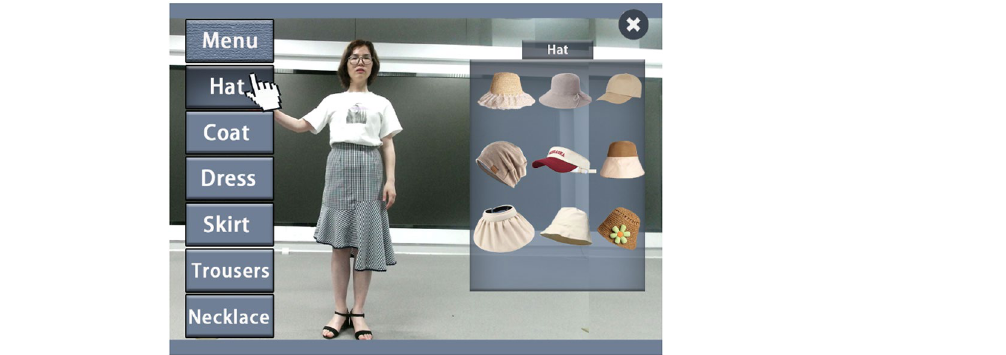
Figure 9. Flow chart of shared somatosensory data